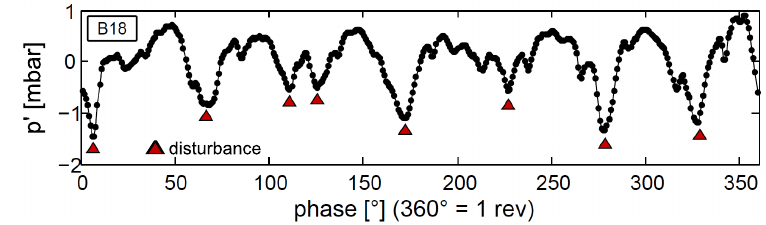
Figure 4. Filtered pressure fluctuations at B18; Difference between mean blade passing (black line in Figure 3b) and the first revolution (one exemplary red